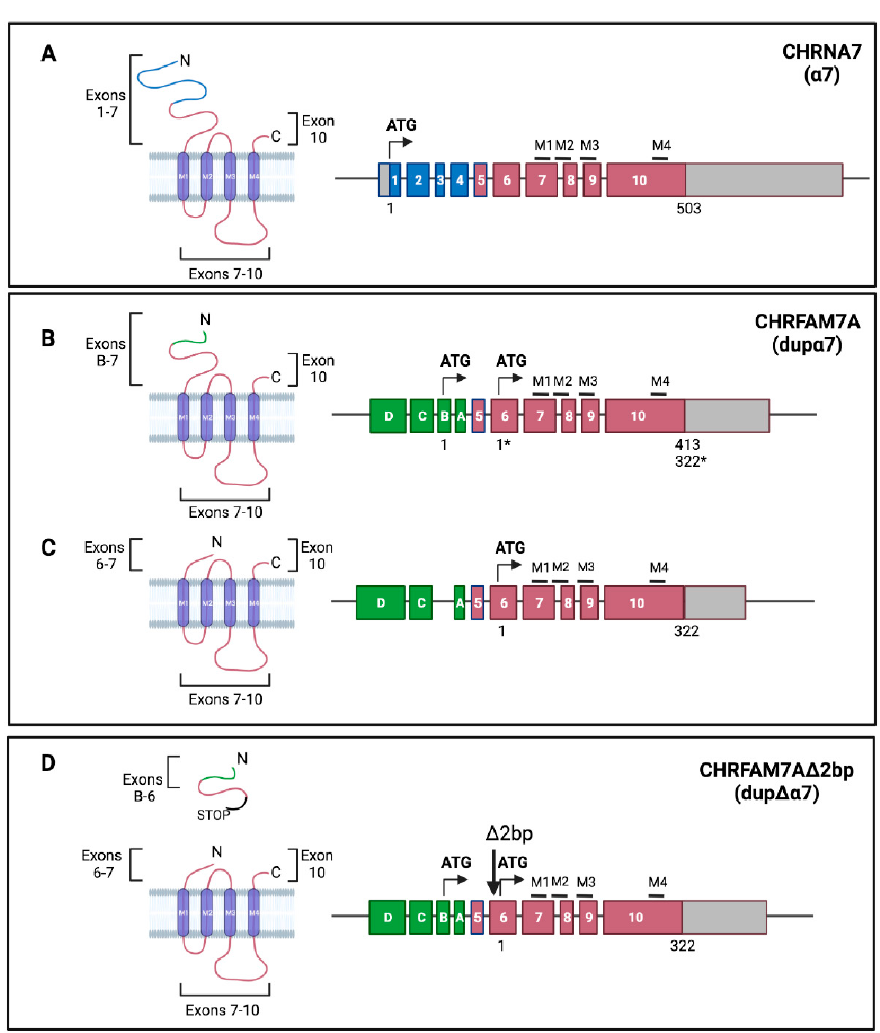
Figure 3. The α 7 and dup α 7 receptor. Relative protein products of CHRNA7 and CHRFAM7A . ( A ),